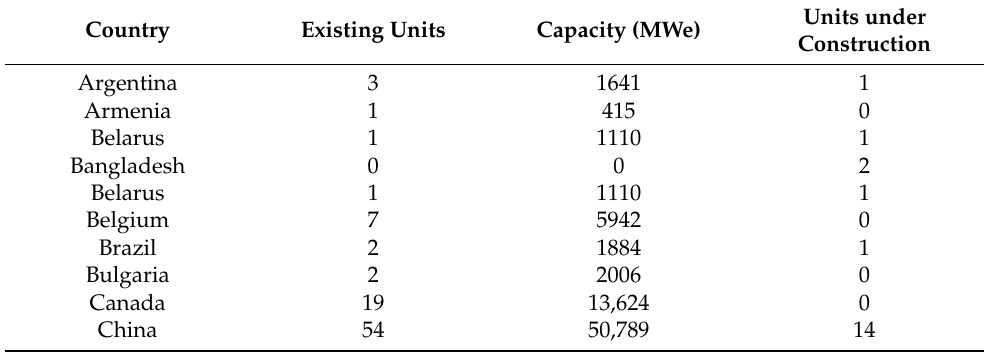
Table 3. Global state of nuclear power plants by country (February 2022) [World Nuclear Association], [IAEA Power Reactor Information System],